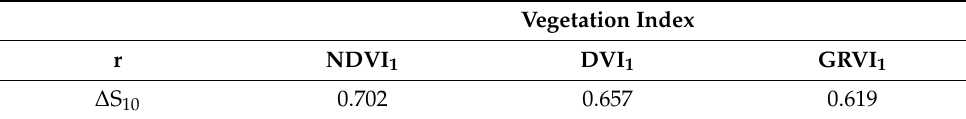
Figure 8. The trend surface of the residuals in the test area B. Table 6. Correlation coefficient between vegetation indexes and residual error Δ S 10 .